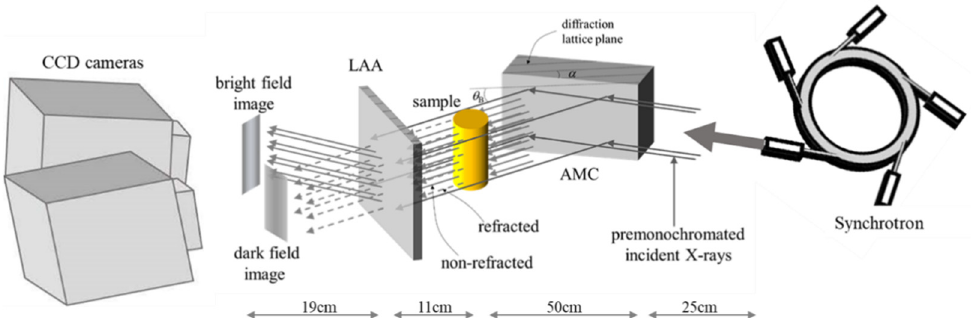
Figure 1. Beamline setup for X-ray dark-field imaging (XDFI) acquisition in BL 14B of Photon Factory. The distance from the beam source to the asymmetrically cut monochromator collimator (AMC) was approximately 25 m, AMC to sample was 50 cm, sample to Laue angle analyzer (LAA) was 11 cm and LAA to camera was 19 cm. Θ B is the Bragg angle, and the angle between the diffracting planes and the crystal surface is α . The acceptance angle of AMC is given by ω i = ω s / √ b. In this equation, ω s is the intrinsic width of reflection curve in a symmetric case and b is the asymmetric factor calculated according to the following equation: b = sin ( Θ B − α )/ sin ( Θ B + α ) = sin (12.010.2)/sin (12.0 + 10.0) = 0.083, which means the AMC can improve X-ray divergence by a factor b (0.083) [9]. An X-ray beam could suffer from refraction when it passes through the specimen. The refracted beam was forward diffracted by the LAA, which contributed to dark-field imaging.